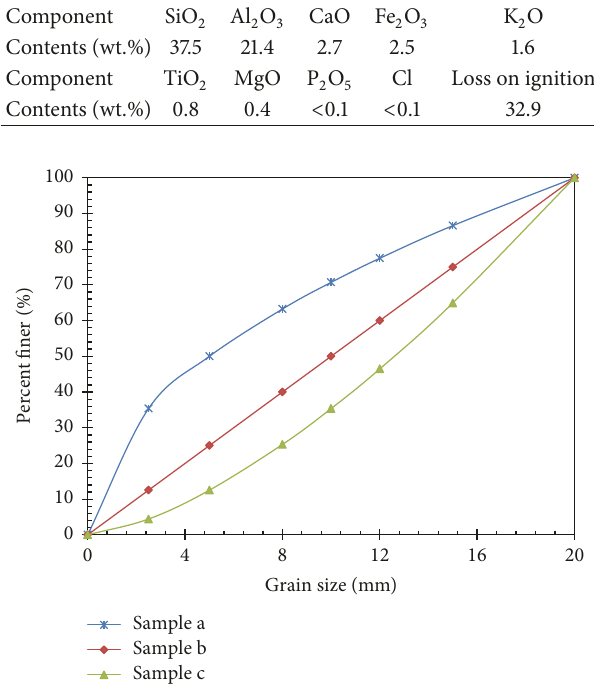
Figure 2: Grain size distribution of each